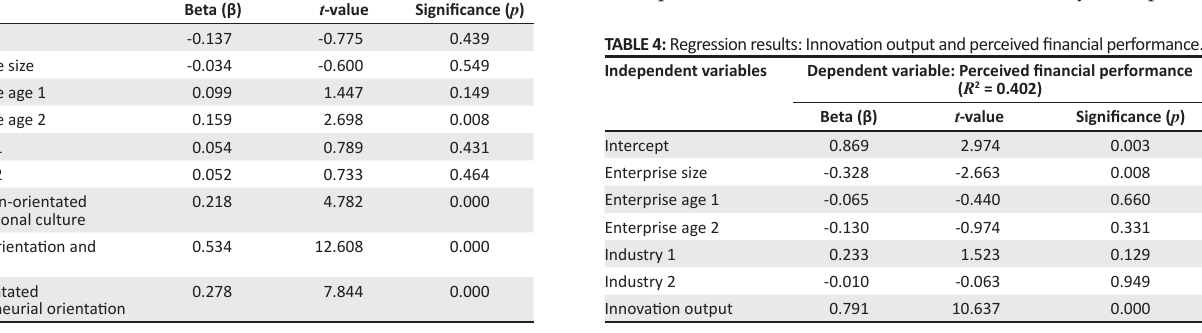
TABLE 3 : Regression results: Independent variables and Innovation output. Independent